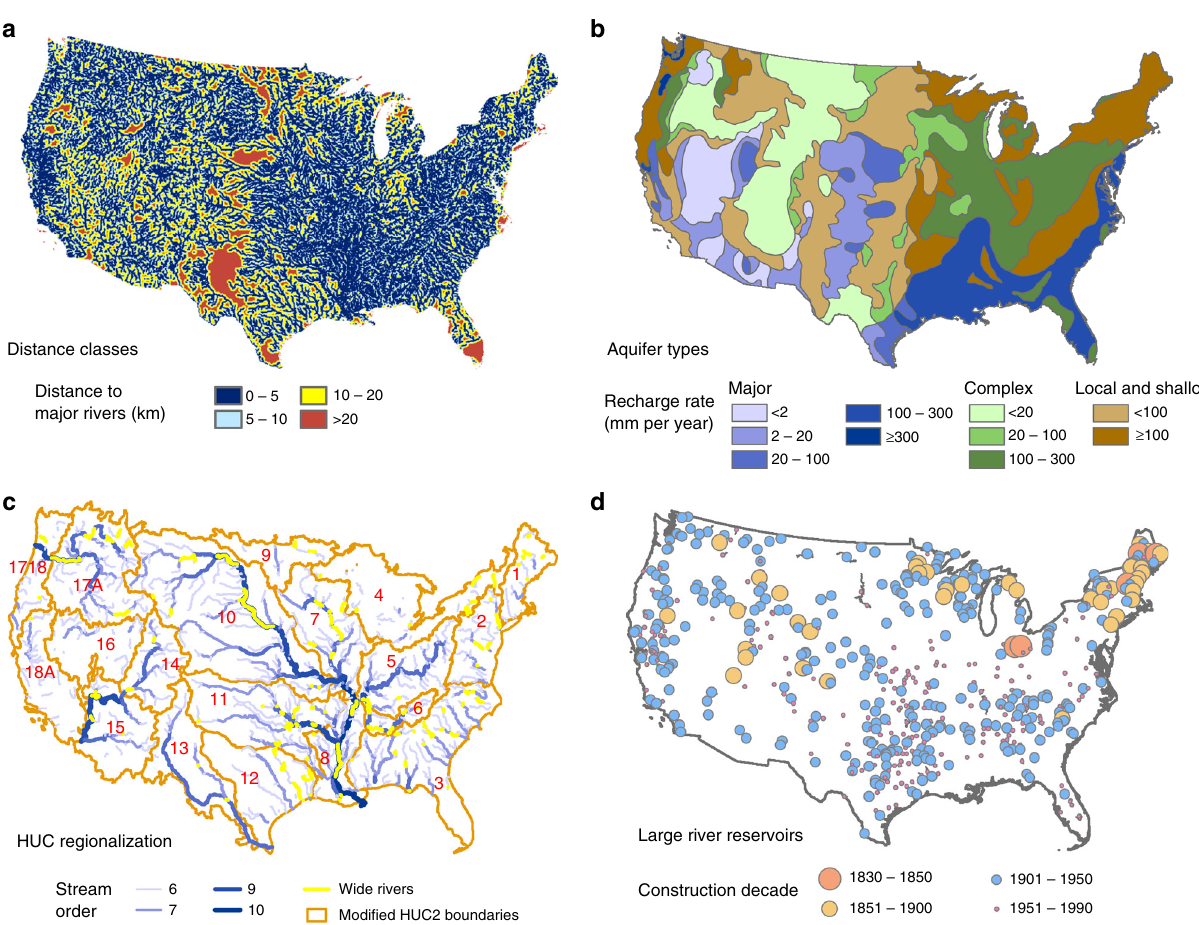
Fig. 1 Rivers, aquifer types, reservoirs, and regions in the conterminous US. a Calculated distance to major rivers (stream order ≥ 4) for each pixel (1 km × 1 km) considering river width. b Aquifer types based on geologic structure and groundwater recharge rate. c Selected major rivers (stream order ≥ 6) and the modi fi ed boundaries for Hydrologic Unit regions. Yellow indicates rivers wider than 1 km according to the GWRL database. d Large river reservoirs